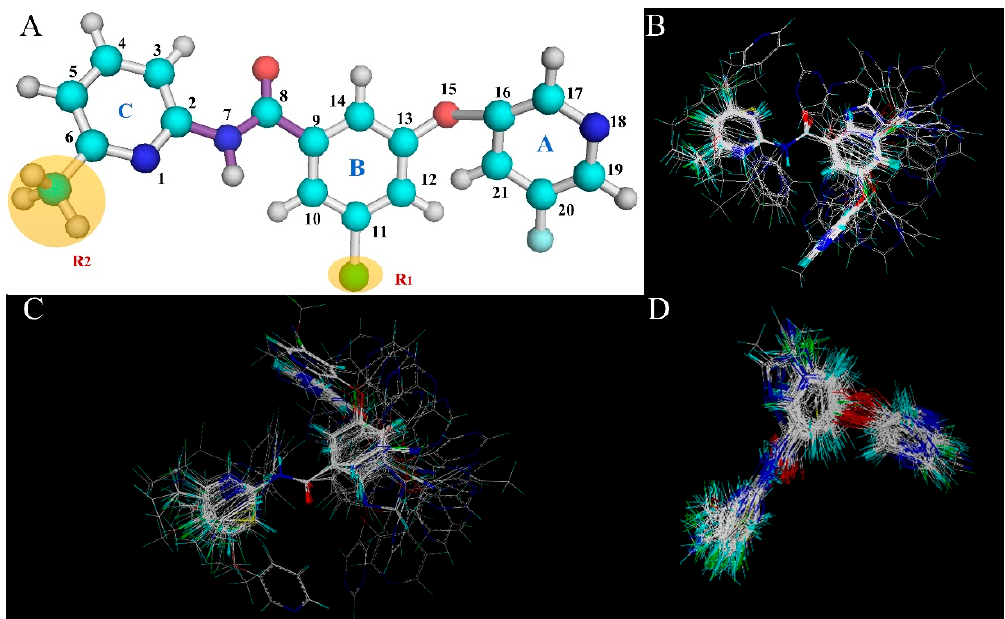
Figure 13. Molecular alignment of all compounds in the dataset. ( A ) The most effective compound 74 is used as a template. The common structure is marked by the purple stick. The molecule is represented by a rod model in which the molecules C, H, N, O, Cl, and F are represented by white, cyan, navy blue, red, green, and blue, respectively. Alignment-I, -II, and -III of all the compounds are shown in panels ( B ), ( C ), and ( D ), respectively.